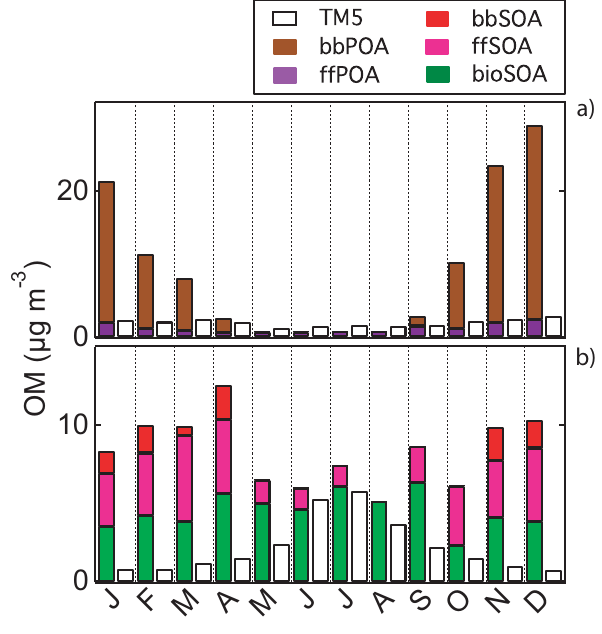
Fig. 4. Comparison of POA (panel a ) and SOA (panel b ) simulated by TM5 model (white boxes) and calculated based on 14 C and tracer